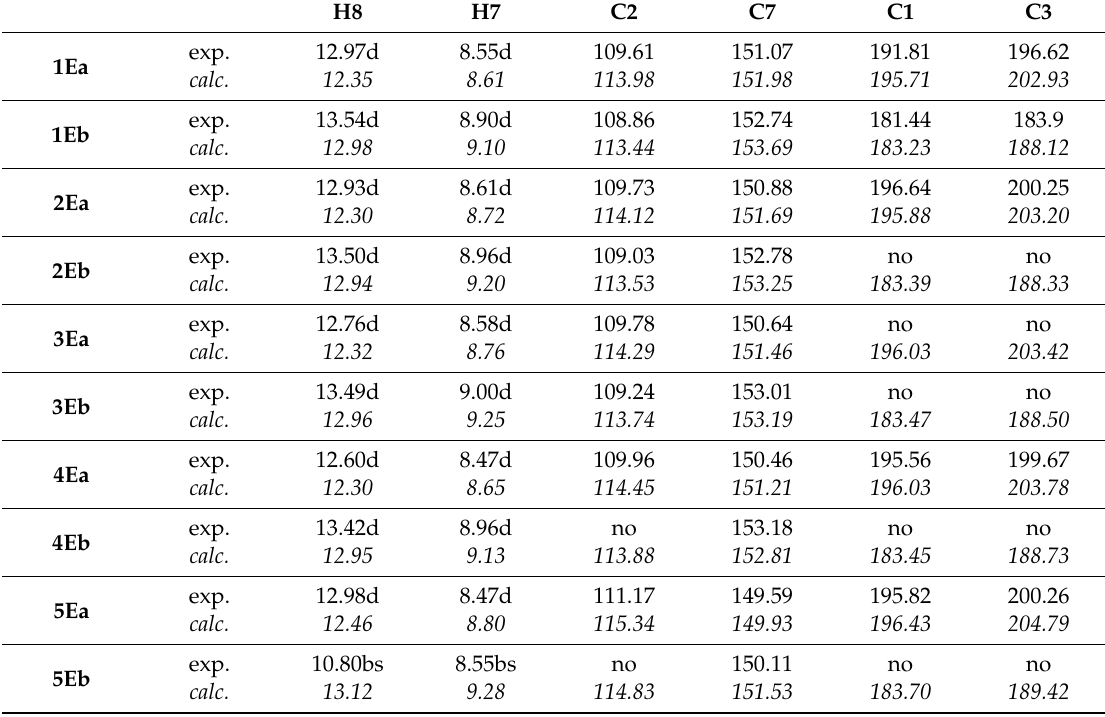
Table 1. Selected 1 H and 13 C NMR chemical shifts ( δ ) for 1–5 in 0.1–0.2 M solutions in DMSO-d 6 at